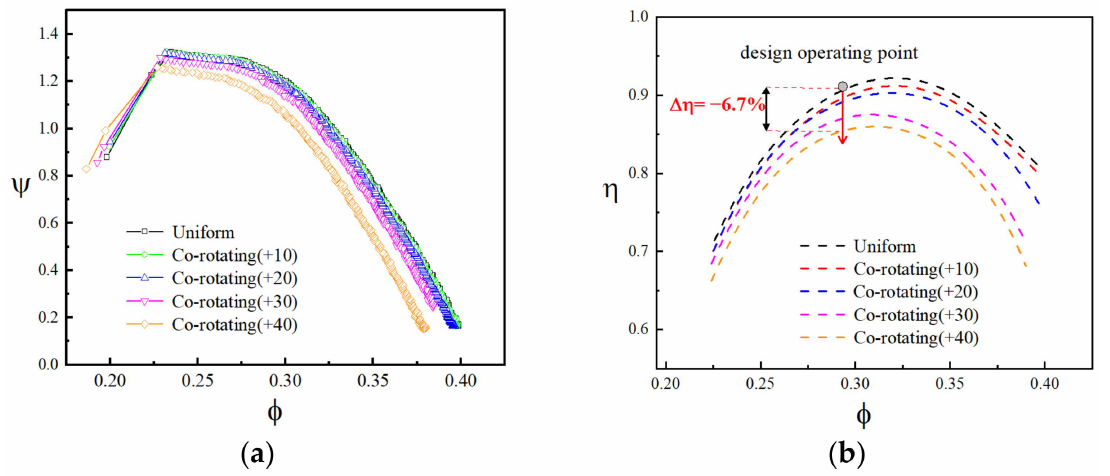
Figure 8. ( a ) Total-to-static pressure rise curves and ( b ) efficiency curves under the inlet co-rotating bulk swirl